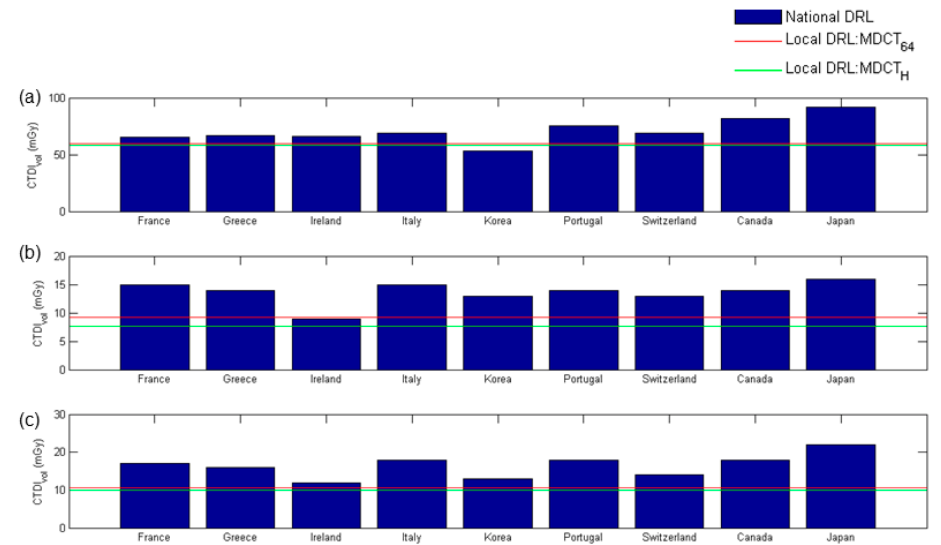
Figure 7. Comparison of local diagnostic reference levels (DRLs) expressed in terms of the 75th percentile CTDI vol with published national DRLs for adult patients undergoing ( a ) head, ( b ) chest, and ( c ) abdominal scans.